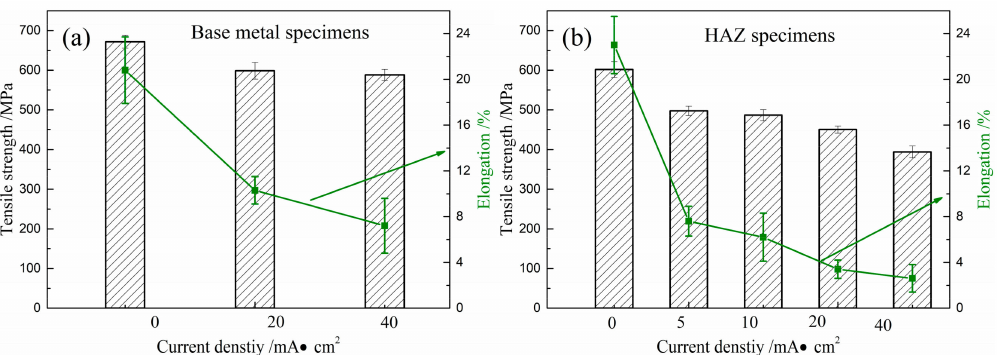
Figure 6. The trend in the tensile strength and elongation of the base metal samples ( a ) and the HAZ samples ( b ) at failure during hydrogen charging at di ff erent current densities.